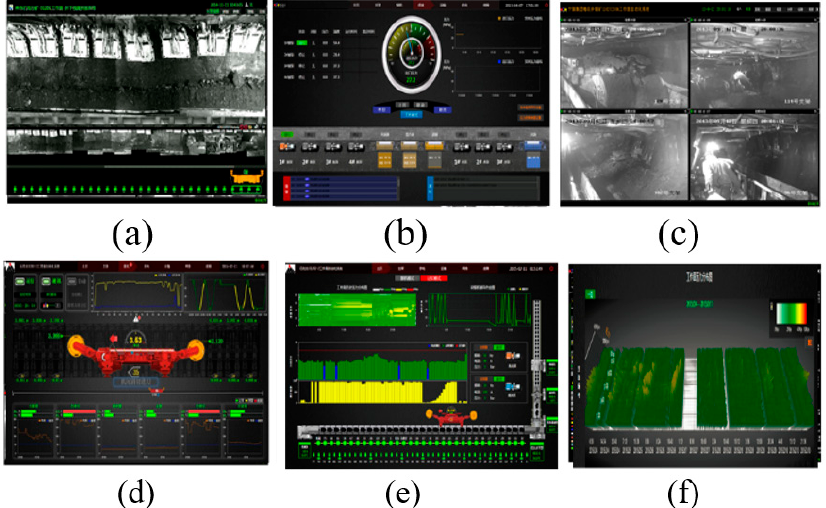
Figure 6. Centralized control software screen of comprehensive mining equipment: ( a ) coal wall monitoring system, ( b ) hydraulic pump monitoring system, ( c ) coal shearer monitoring system, ( d ) hearer detection system monitors the relevant data of the shearer, ( e ) statistics of the use of the shearer, ( f ) 3D cene model of the stope.